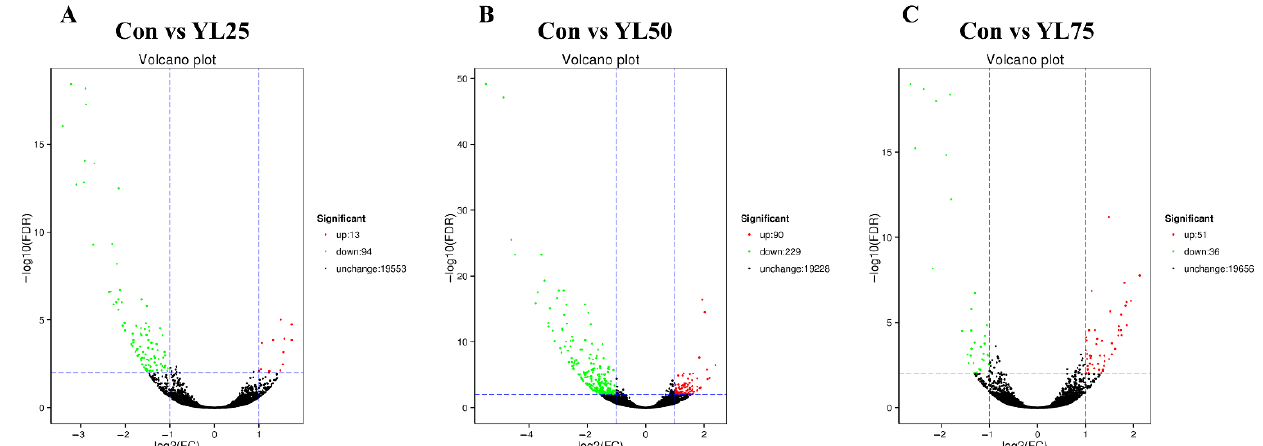
Figure 5. Volcano plot of differentially expressed genes in the YL25 treatment vs. the control treatment ( A ), the YL50 treatment vs. the control treatment ( B ), and the YL75 treatment vs. the control treatment ( C ). The x-axis shows the fold change in gene expression between the control treatment and the YL treatments, and the y-axis shows the statistical significance of the differences. Red splashes represent significantly upregulated genes. Green splashes represent significantly downregulated genes. Black splashes indicate no difference. Con was the control diet. In the other three diets, 25%, 50%, 75% of the fish meal was replaced with YL. The diets were named YL25, YL50, and YL75, respectively.